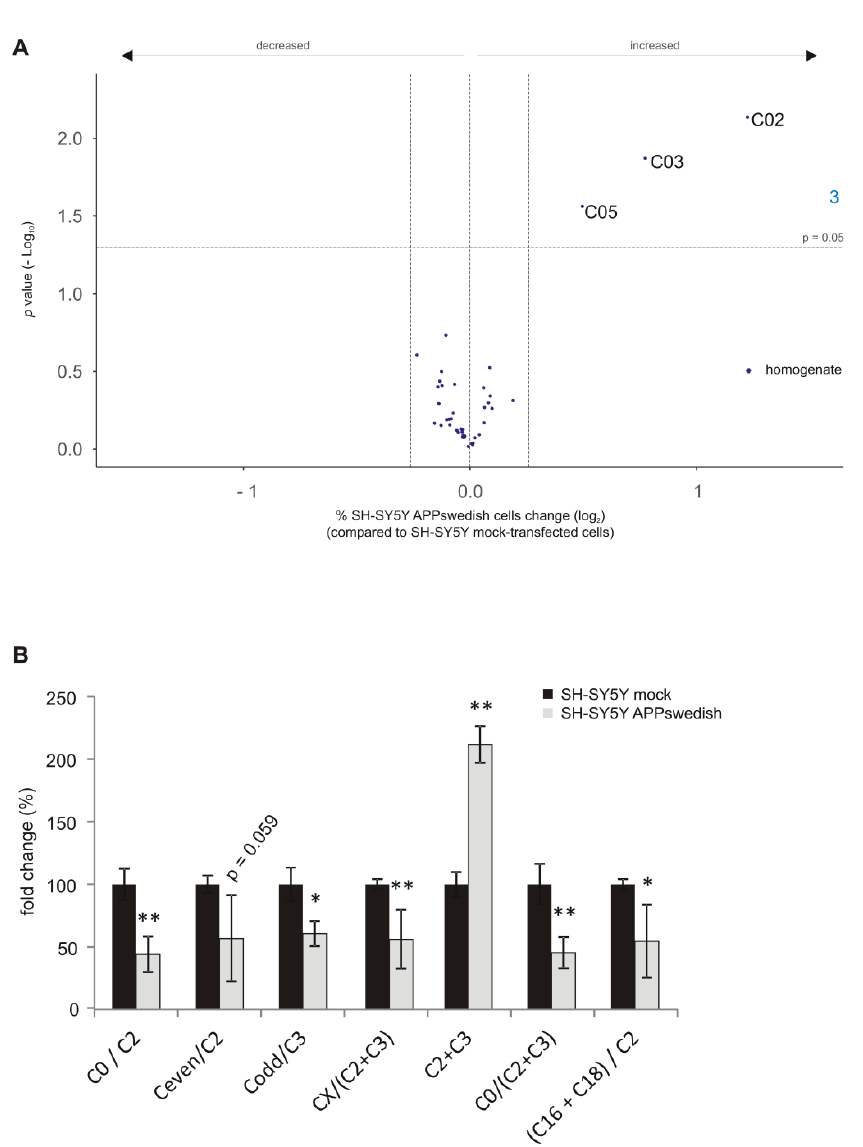
Figure 9. Changed carnitine levels in homogenates of SH-SY5Y APPswedish cells in comparison to mock-transfected SH-SY5Y cells. ( A ) The fold changes of single carnitine species in homogenates are shown as volcano plots. Vertical dashed lines next to 0.0 represent the average SEM and the horizontal dashed line marks p = 0.05. ( B ) The fold changes of C0/C2−, Ceven/C2−, Codd/C3−, CX/(C2 + C3)−, C2 + C3−, C0/(C2 + C3)− and (C16 + C18)/C2 ratios in SH-SY5Y APPswedish cells